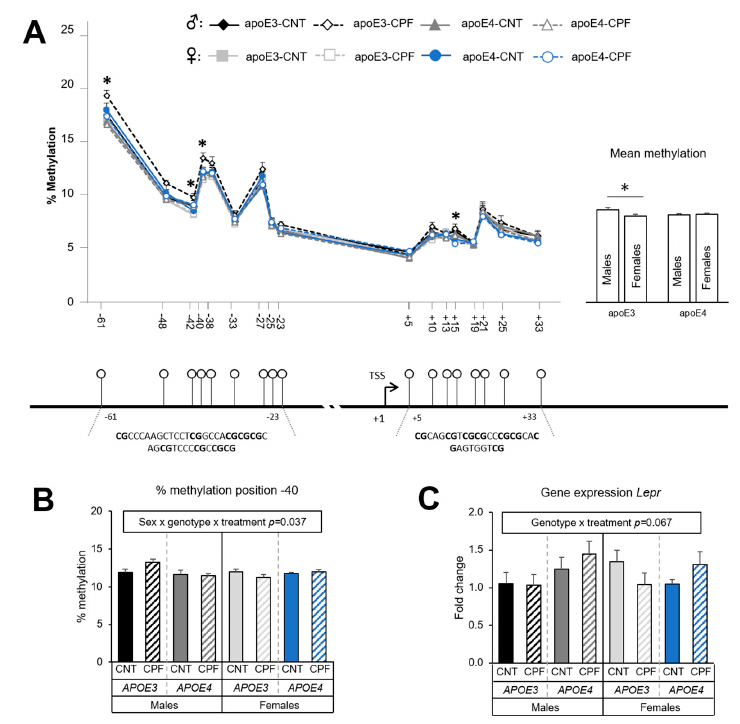
Figure 4. Lepr gene methylation at the CpG positions studied in the target zone in the promoter and overall methylation levels, which are sharing the same y axis. Below, there is the graphical representation of the CpG positions studied and the exact sequence of the target region ( A ). Methylation at the specific position − 40 ( B ) and gene expression of the Lepr gene ( C ). All groups included 6 animals except for the APOE3 -CNT that included 5. An asterisk (*) indicates significant differences between groups at p < 0.05. Abbreviations: CNT, control; CPF, chlorpyrifos-treated. Data is contained within the Supplementary File S1.